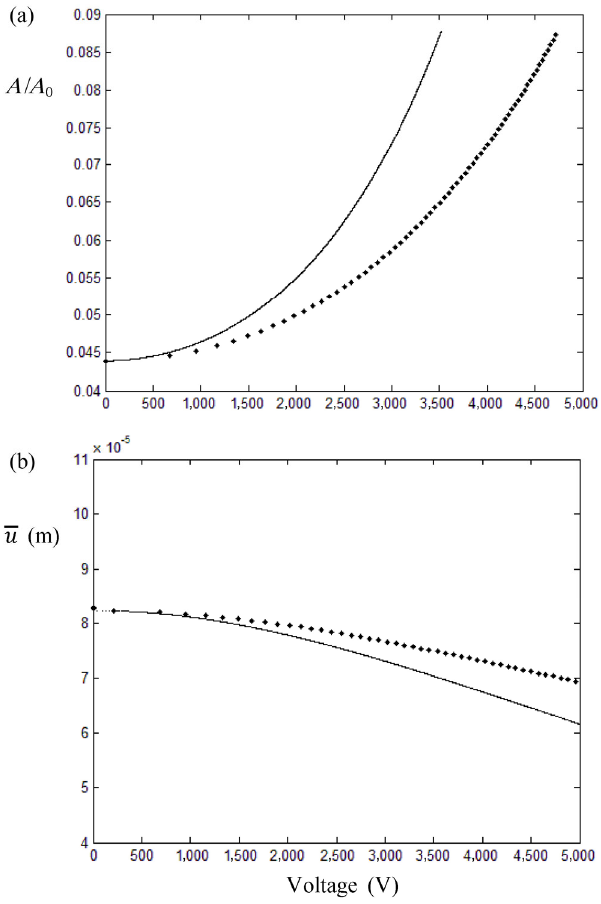
Fig. 2 (a) Normalized contact area A A  and (b) average sur- Fig. 3 (a) Normalized contact area A A  and (b) average sur- 0 0 face separation u as a function of the applied voltage for the face separation u as a function of the applied voltage for the wrist skin, with the effective Young’s modulus 1 MPa E   and wrist skin, with the effective Young’s modulus 10 MPa E   and 10 kPa p  . The roughness effects of the SC layer are considered 10 kPa p  . The roughness effects of the SC layer are considered 0 0 for the data shown by the solid curve, while the roughness effects for the data shown by the solid curve, while the roughness effects are not included for the data shown by the dotted curve. are not included for the data shown by the dotted